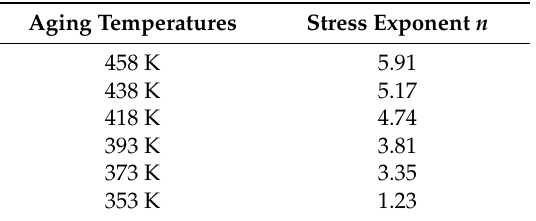
Figure 4. Relationship between steady creep rate and experimental stress σ of 2219 aluminum alloy at different aging temperatures. ( a ) 458 K, 438 K and 418 K; ( b ) 393 K, 373 K and 353 K. Table 3. Stress exponents of 2219 aluminum alloy at different aging temperatures.